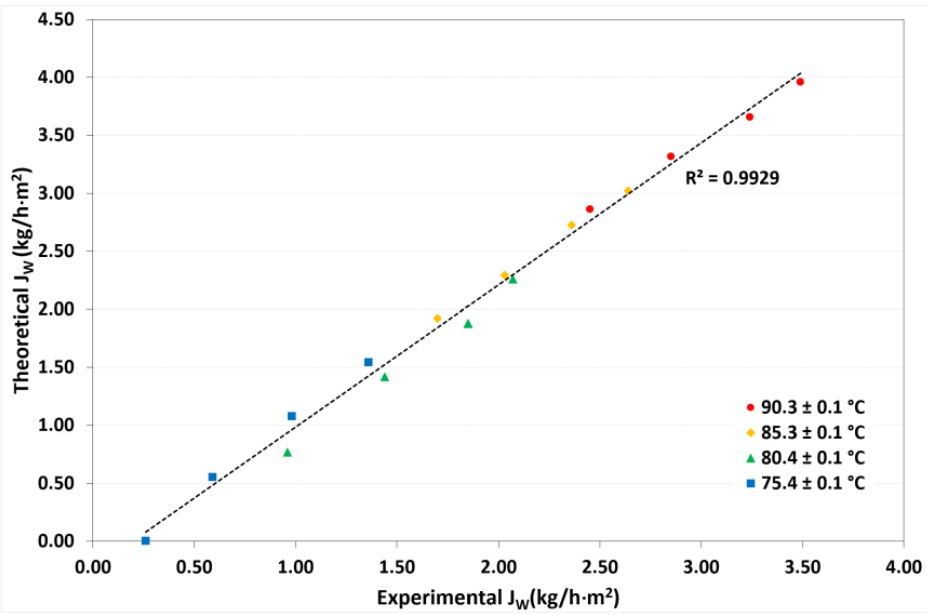
Figure 9. Comparison between theoretical and experimental desorption rates.